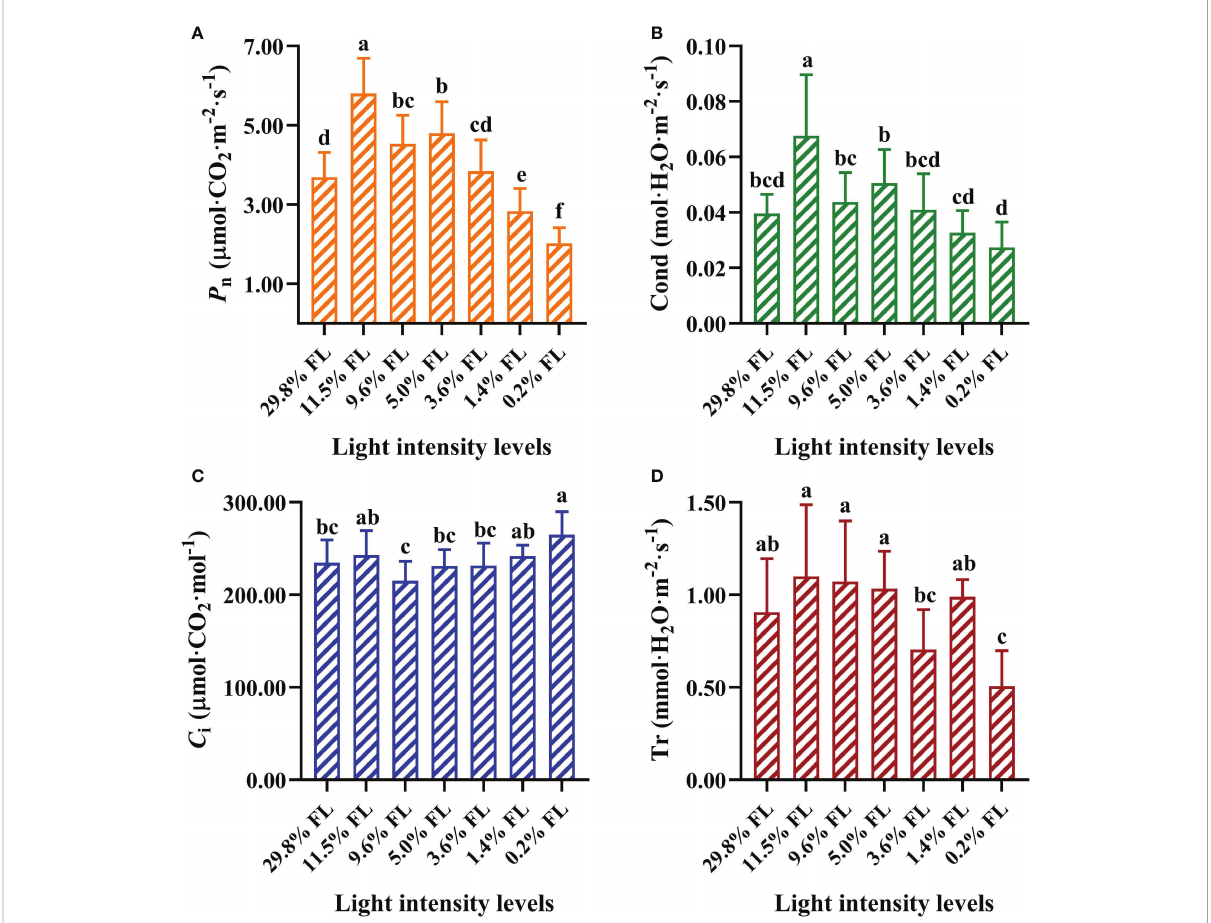
FIGURE 2 Effects of long-term light treatments on gas exchange parameters in Panax notoginseng leaves. (A) Net photosynthesis rate ( P n , m mol·CO 2 ·m - 2 ·s -1 ). (B) Stomatal conductance (Cond, mol·H